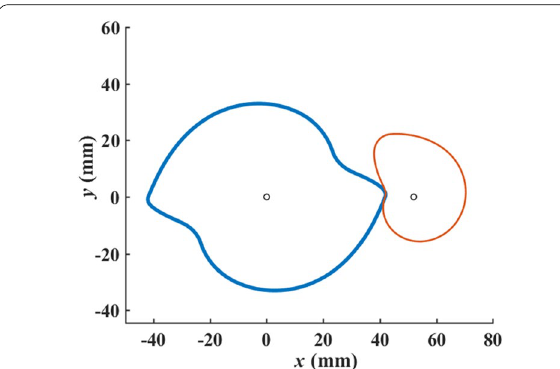
Figure 6 Pitch curve of the symmetrical-transmission second-order non-circular gear train The gear-pitch curve of the gear train can be calculated according to Eqs. (1)–(3), where a is the center distance between the two gears. The gear-pitch curves are shown in Figure 6.